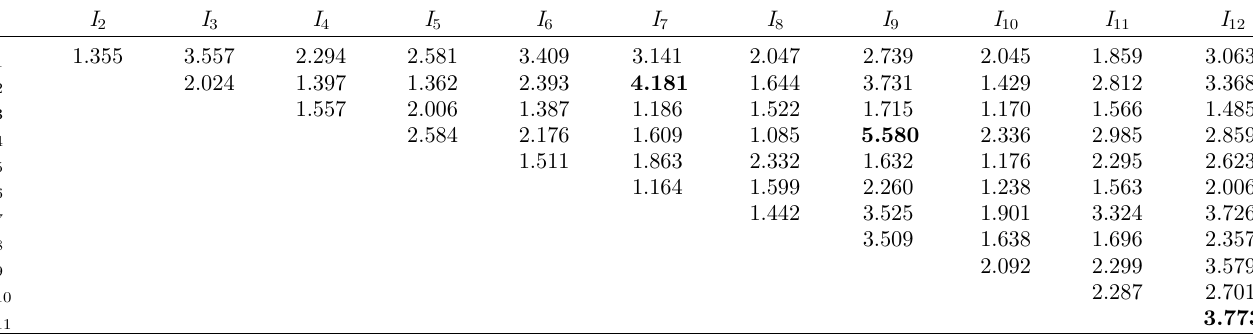
g (see Eq. (4) and Remark 2). In bold type, the three highest values. I